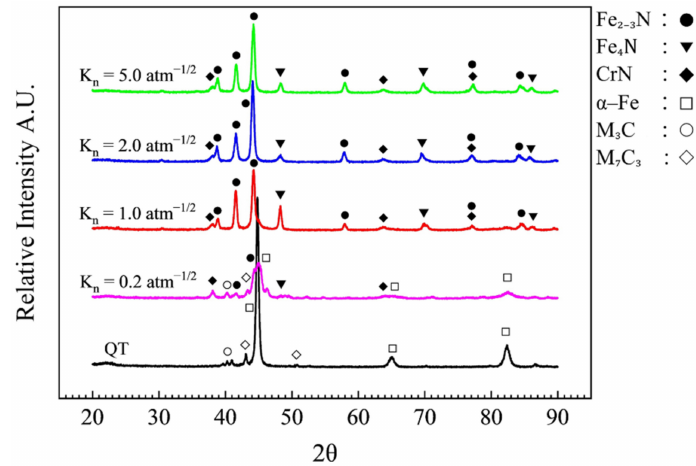
Figure 4. X-ray diffraction pattern of the QT and nitrided specimens.